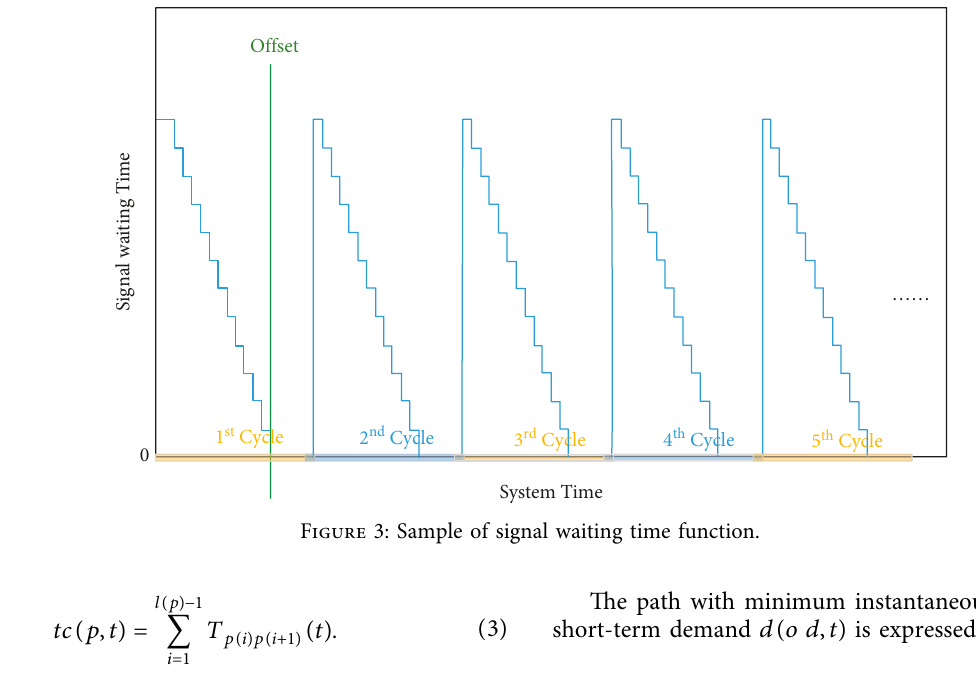
Figure 3: Sample of signal waiting time